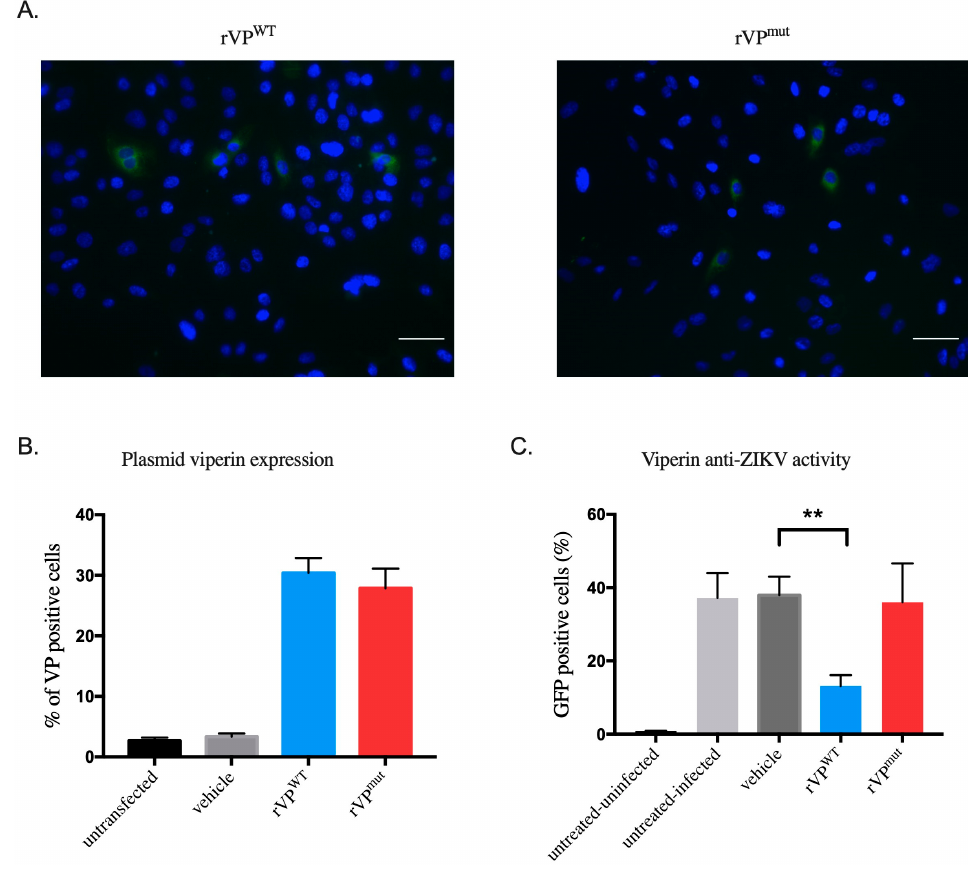
Figure 2. Anti-Zika virus activity of recombinant viperin in HK-2 NGC cells. Expression of recombinant wild-type viperin (rVP wt ) and recombinant mutant viperin (rVP mut ) proteins in HK-2 NGC cells detected by immunofluorescence assay ( A ) and flow cytometry ( B ). Viperin (green) and nuclei (blue) were visualized by fluorescence microscopy. ( C ) Anti-ZIKV activity of rVP WT in HK-2 NGC cells. HK-2 cells were infected with ZIKV GFP and GFP-positive cells were quantified by flow cytometry at 24 h post-infection. Results are shown as means ± SD. Unpaired t-test shows that differences are statistically significant (** p < 0.01). Scale bars represent 100 µ